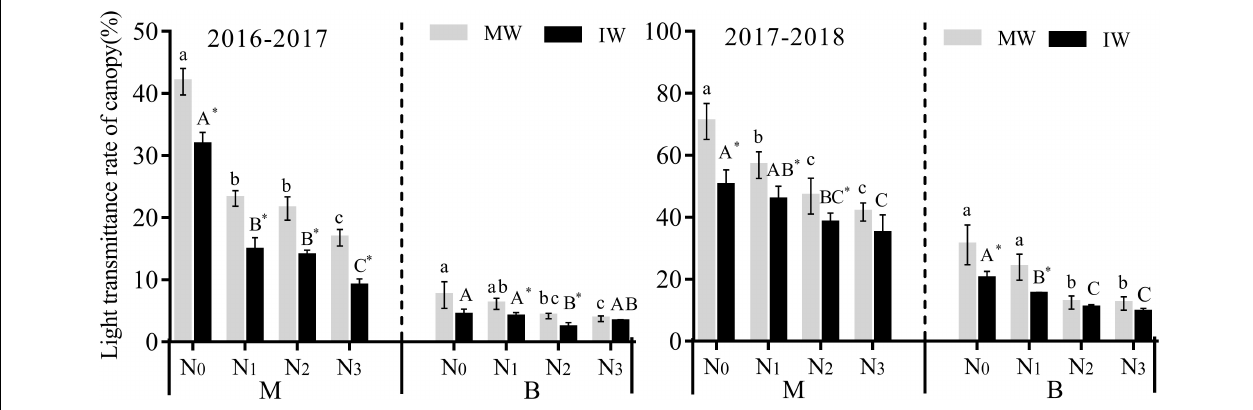
FIGURE 2 | Effects of applied nitrogen and intercropping on light transmittance of wheat canopy. MW, monocropped wheat; IW, intercropped wheat; M, middle of canopy; B, below of canopy. The different capital letters and small letters represent significant differences between different N levels in the same planting pattern at P < 0.05 levels. * Represents significant difference between monocropped and intercropped patterns at the same N level ( P <